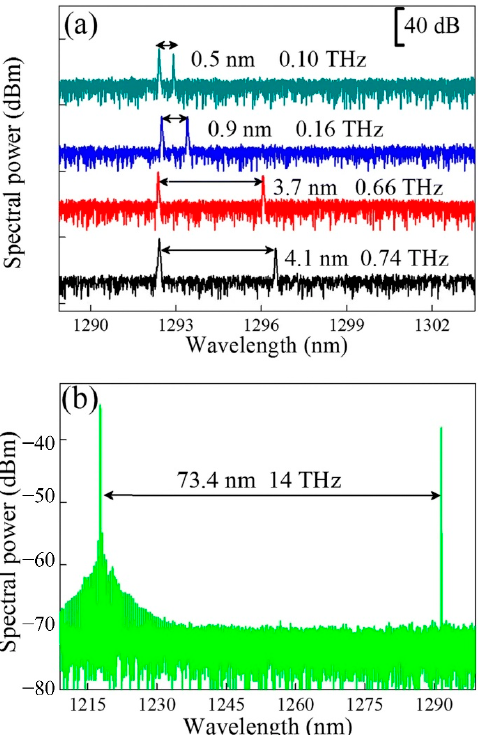
Figure 19. Output spectra of the dual-mode LC-DFB lasers. ( a ) Emission spectra of the dual-wavelength LC-DFB laser with a different grating period. ( b ) Wide spacing of dual-mode lasing spectra of the LC-DFB laser. Reproduced with permission from [136]. Springer Nature, 2018.